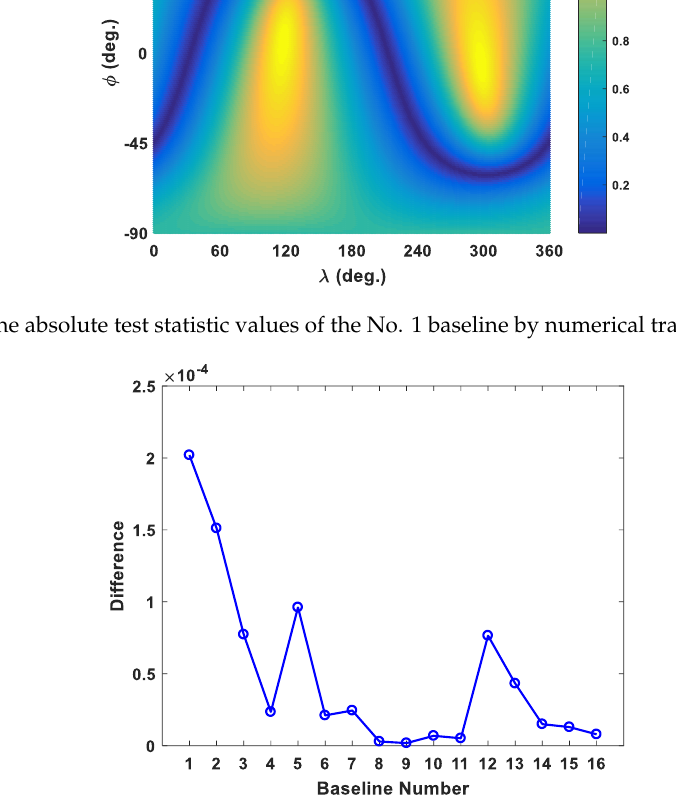
Figure 3. Differences between maximum absolute statistics by two calculation approaches.